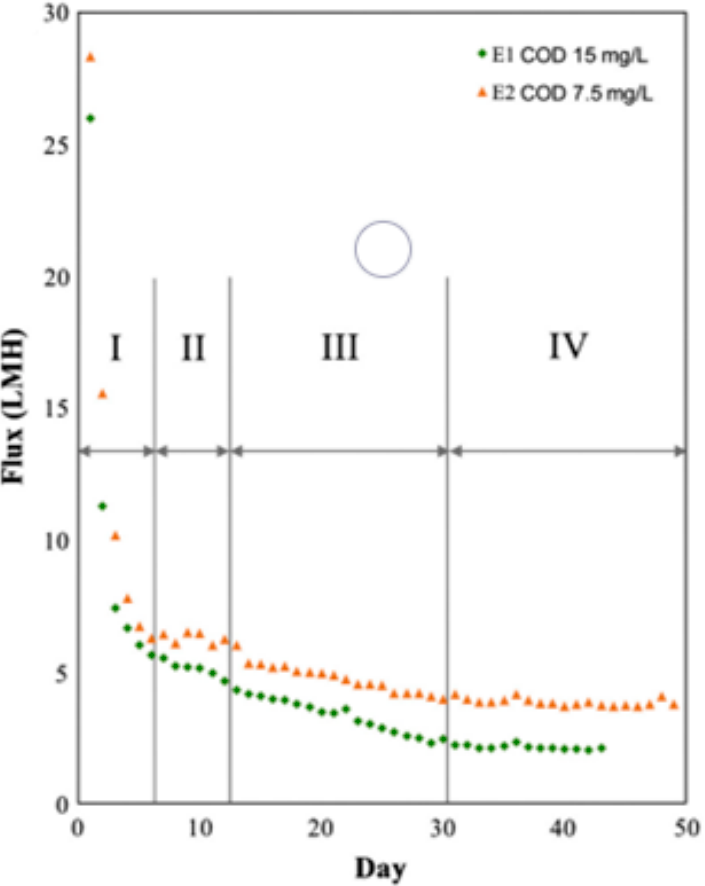
Figure 7. Variations in flux and resistance during the experiments were divided into four phases: flux (initial E1 and E2 were 26 and 28 Lm − 2 h − 1 , respectively). Reprinted with permission from Ref. [63]. Copyright 2014